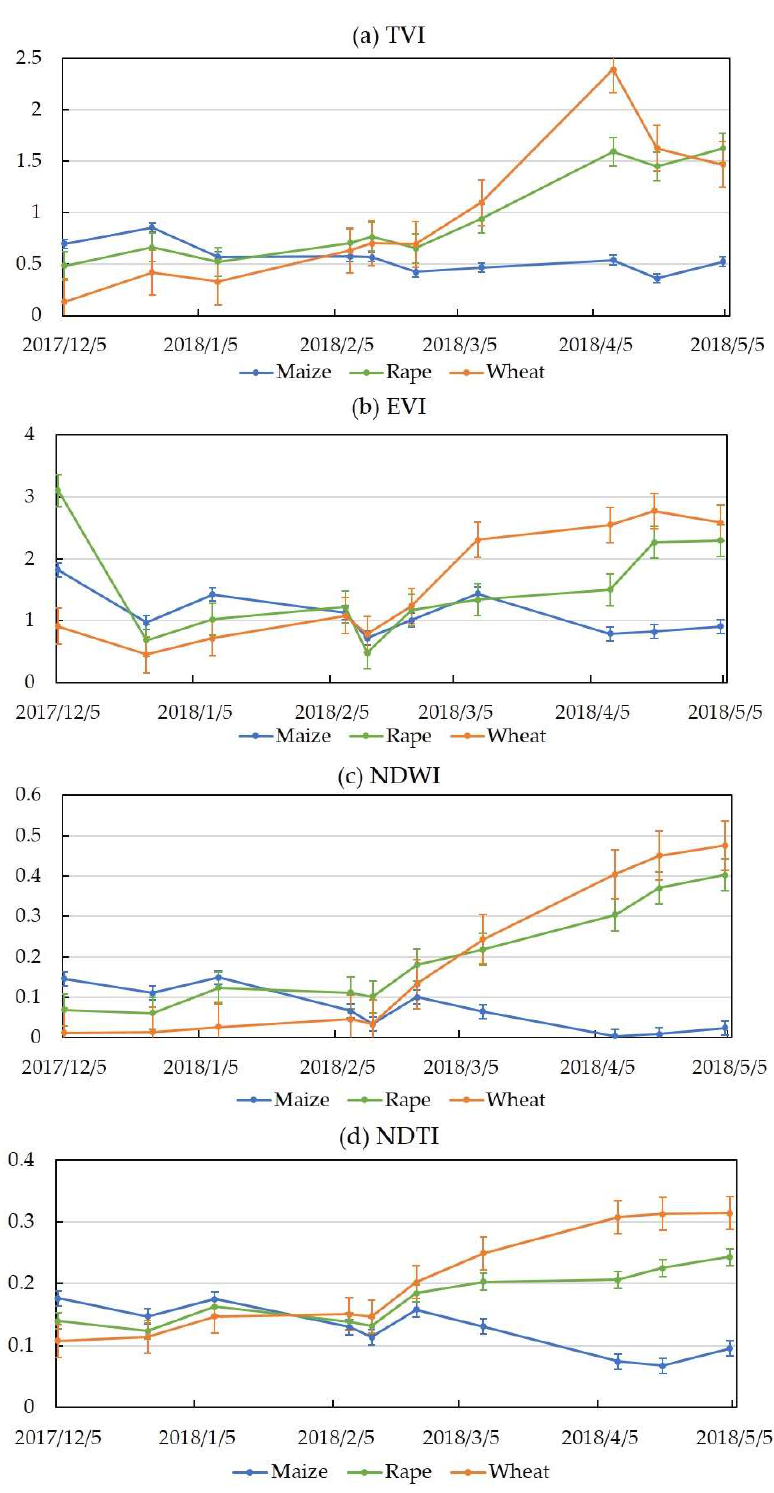
Figure 5. Indices of maize, rape, and wheat in time series for Sentinel-2 data.